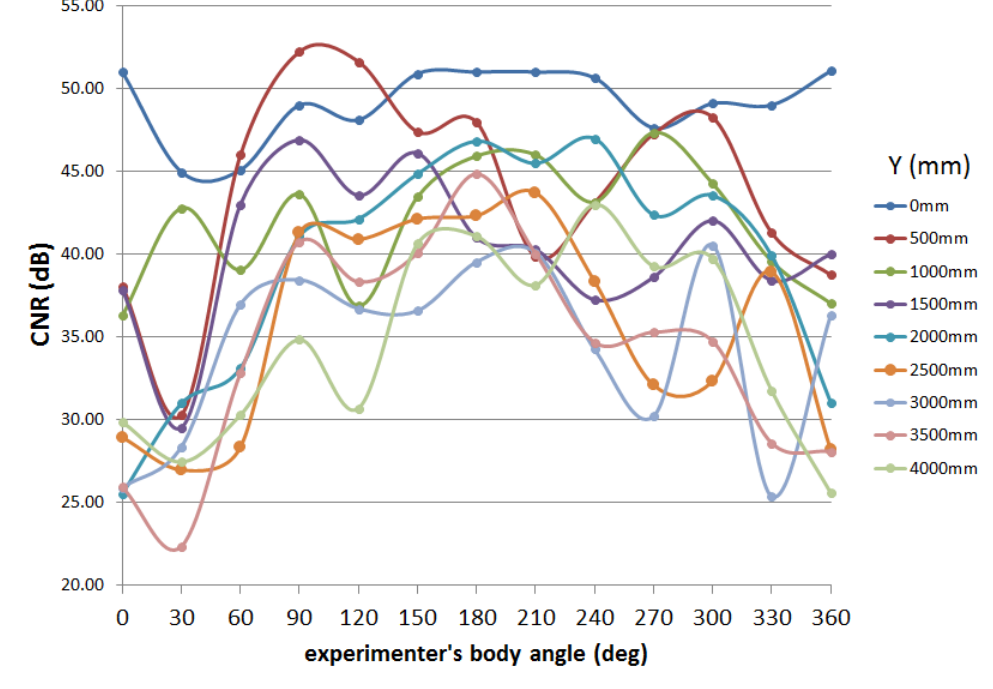
Figure 18. Experimental result of human body